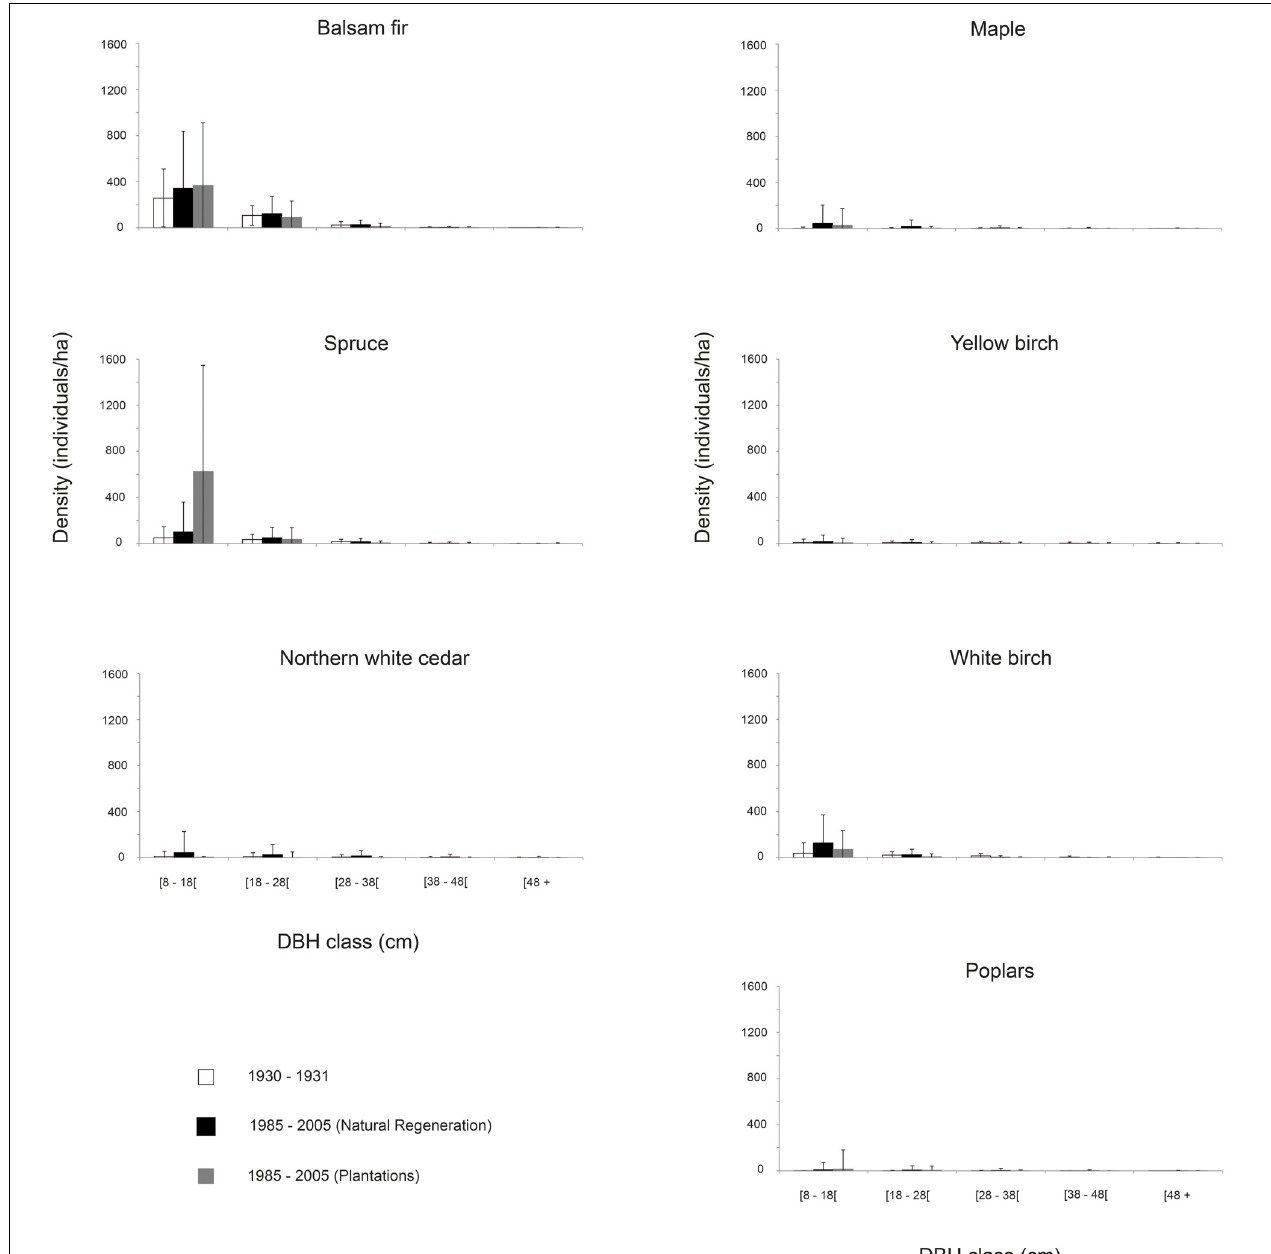
FIGURE 7 | Diameter structure between 1930 and1931 ( N = 16345), 1985–2005 natural regenerated stands ( N = 3795), and 1985–2005 plantations ( N = 385). Bars represent standard